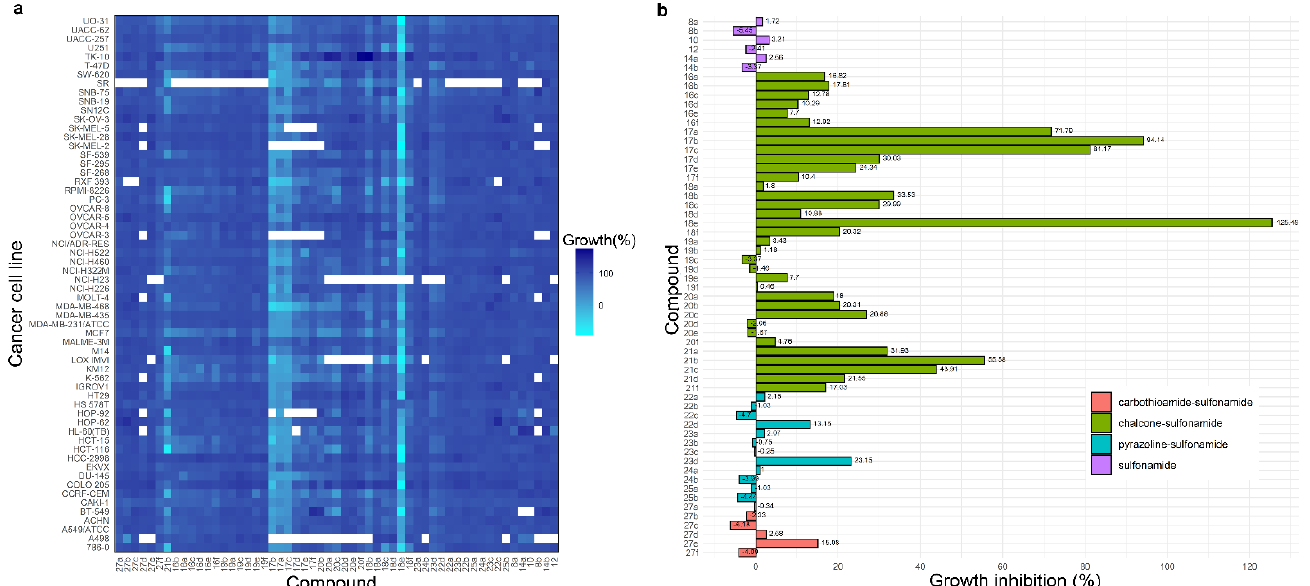
Figure 5. Anticancer activity of the synthesized hybrids at 10 µM. ( a ) Heatmap showing the growth of the cancer cells in presence of the compounds. Reduced growth of the cells is represented in cyan and dark blue represents the high growth of the cells. Blank cells indicate lack of data. ( b ) Mean growth inhibition (GI) percentage for each compound. A GI % value over 100% indicates there is no net growth of tumor cells over the course of the experiment; instead, compound causes the death of the respective cancer cell.